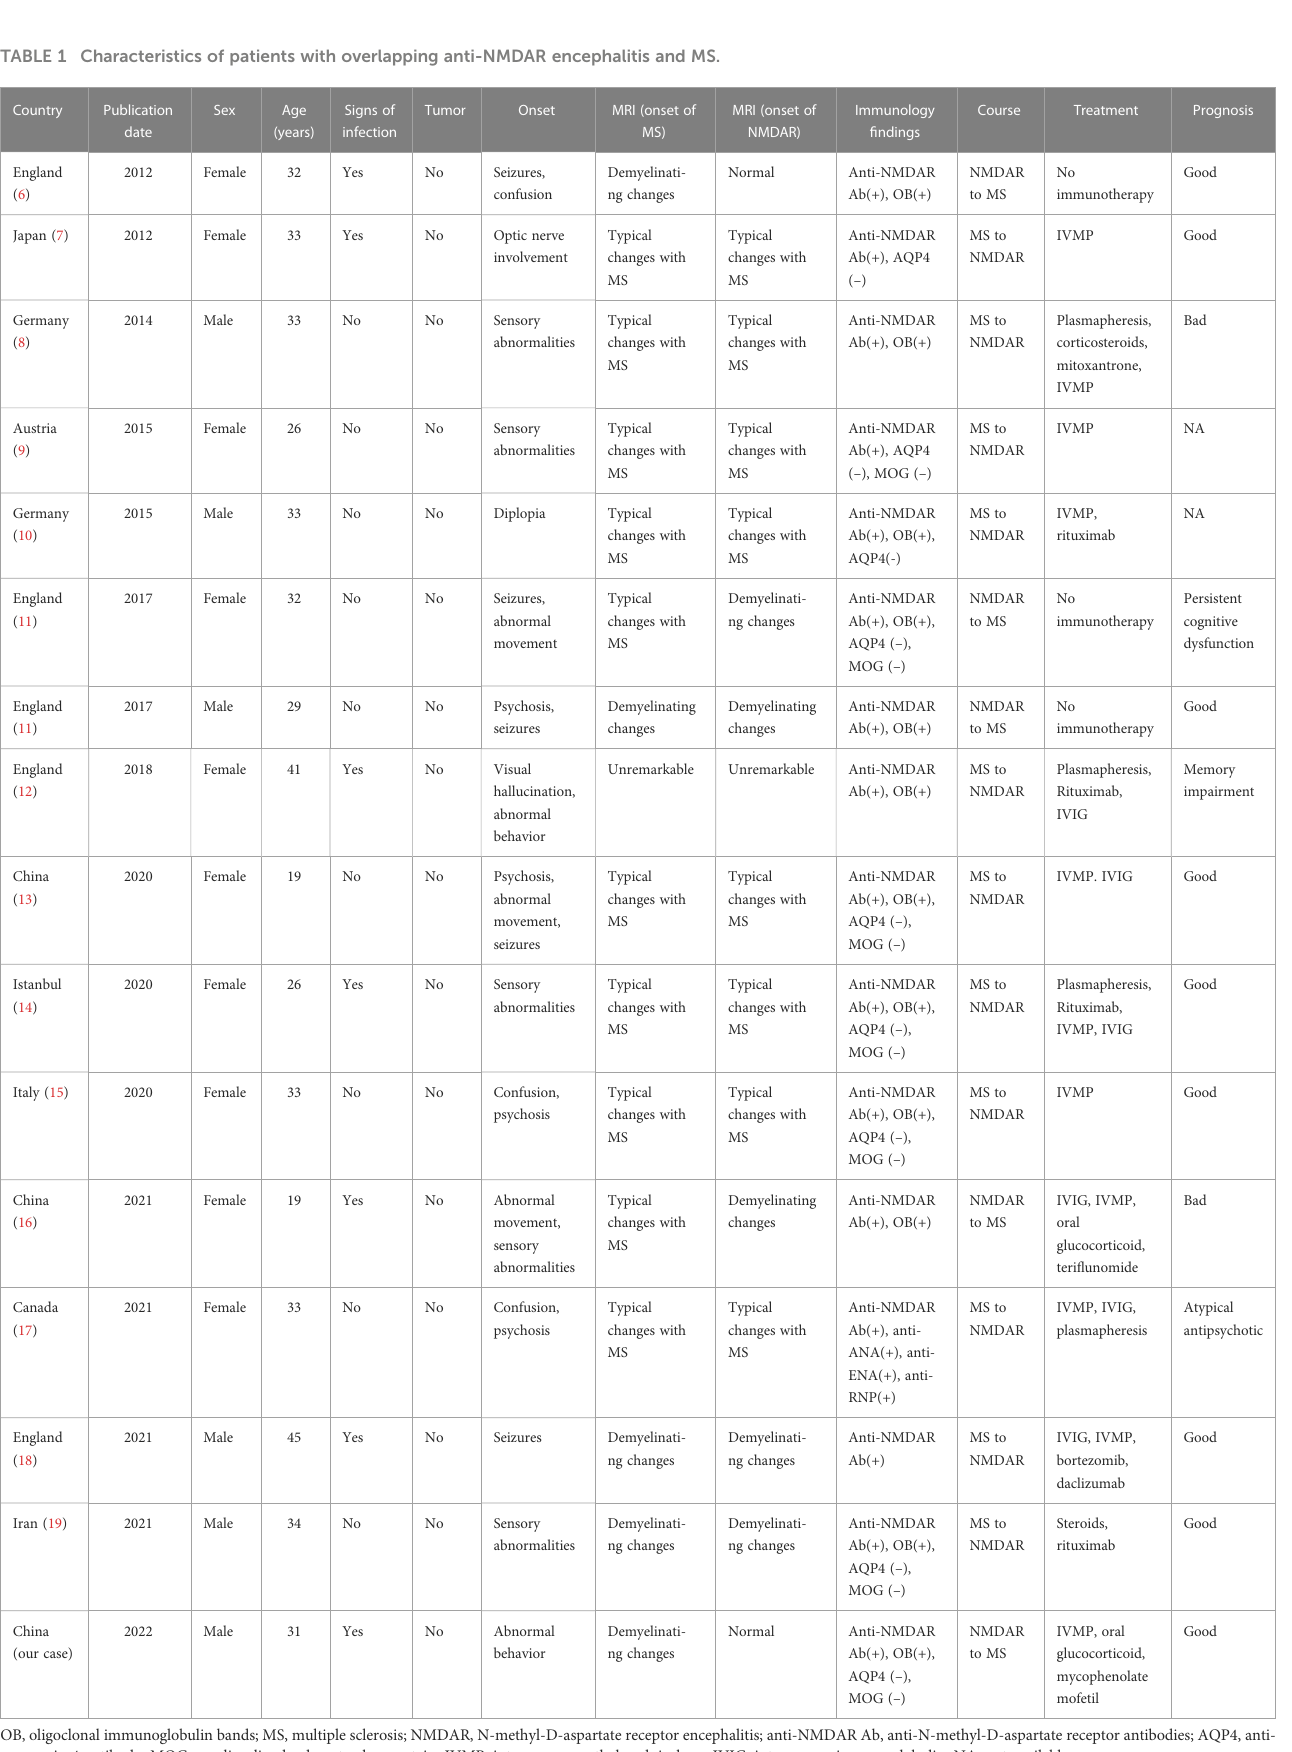
OB,oligoclonal immunoglobulin bands;MS, multiplesclerosis; NMDAR, N-methyl-D-aspartate receptor encephalitis; anti-NMDAR Ab, anti-N-methyl-D-aspartate receptor antibodies; AQP4, anti- aquaporin 4 antibody; MOG, myelin oligodendrocyte glycoprotein; IVMP, intravenous methylprednisolone; IVIG, intravenous immunoglobulin; NA, not